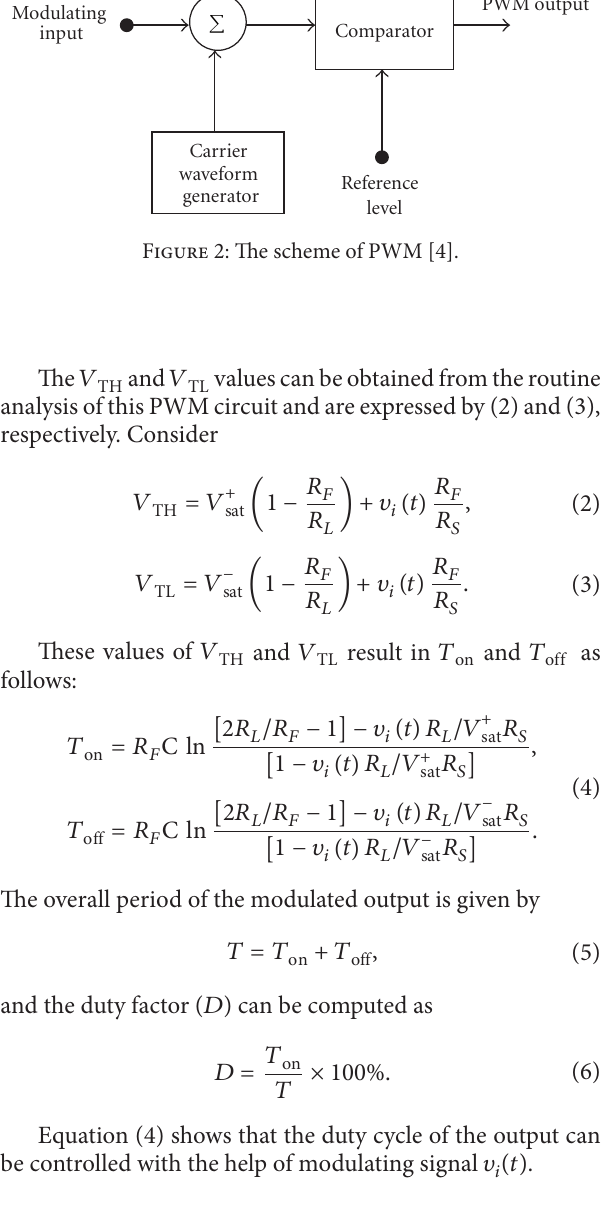
F 1: OTRA circuit symbol. ComparatorModulating ∑ input